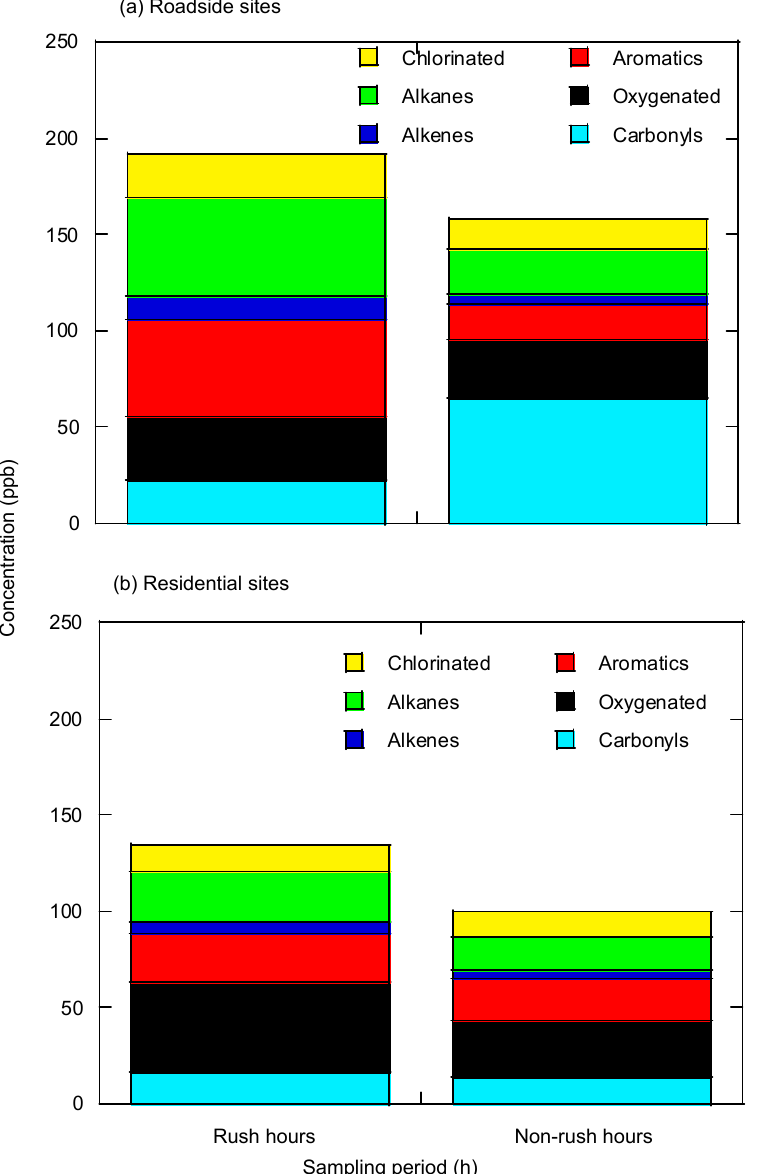
Figure 2. VOC groups distribution at roadside and residential sites for different sampling periods. ( a ) Roadsite sites, ( b ) Residential sites.